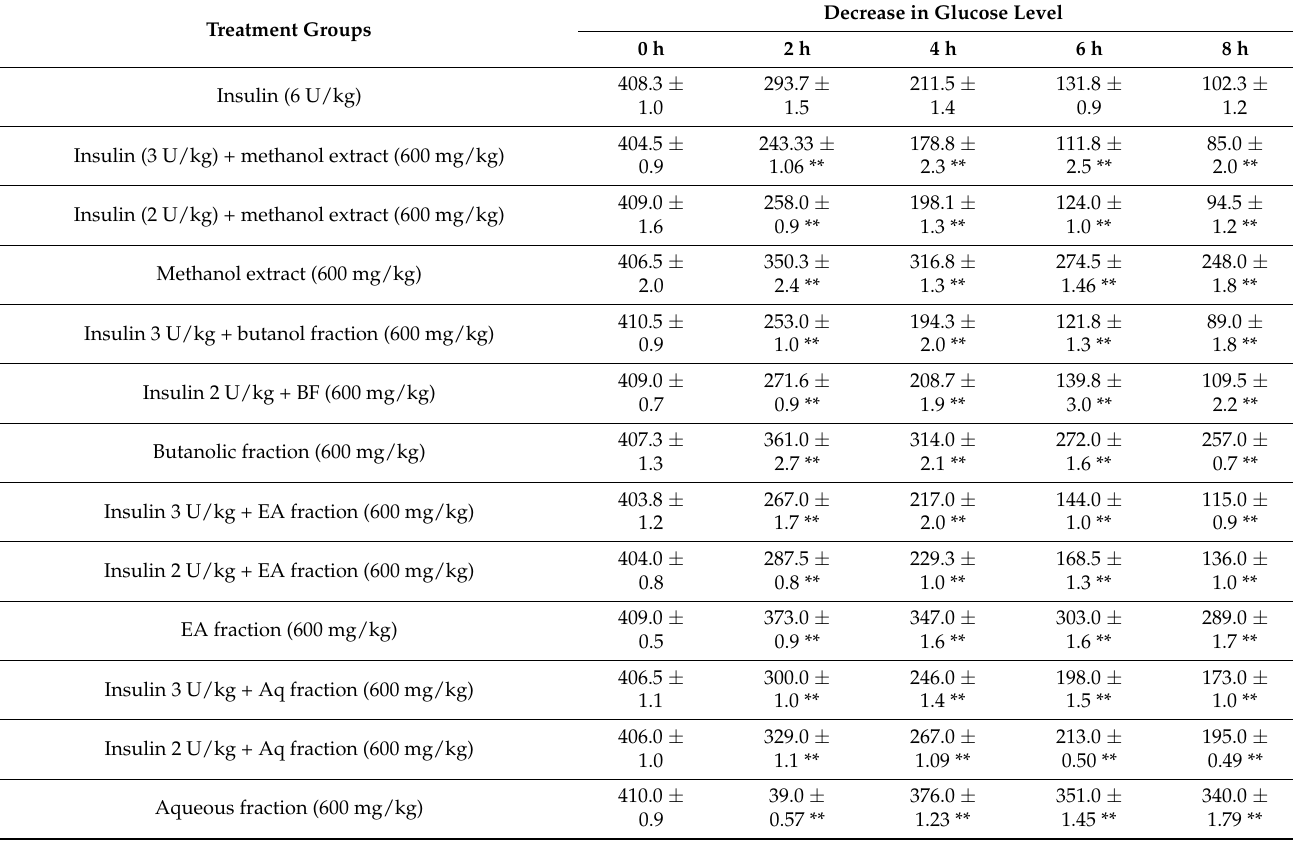
Table 6. Synergistic effect of B. calliobotrys in diabetic rats, with insulin and without insulin. Treatment Groups